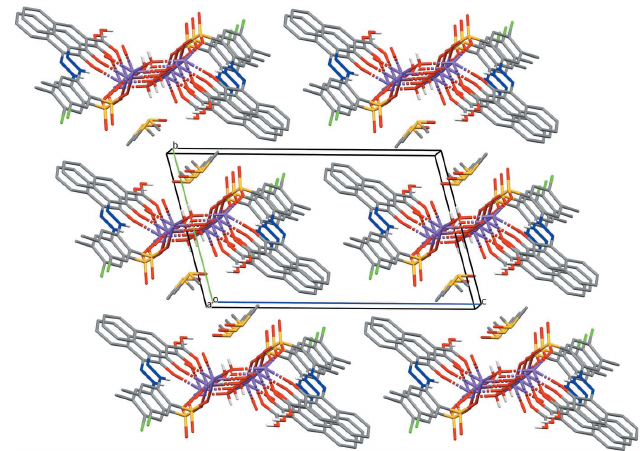
Figure 1 A perspective view of the asymmetric unit of the title compound. Displacement ellipsoids are drawn at the 50% probability level.